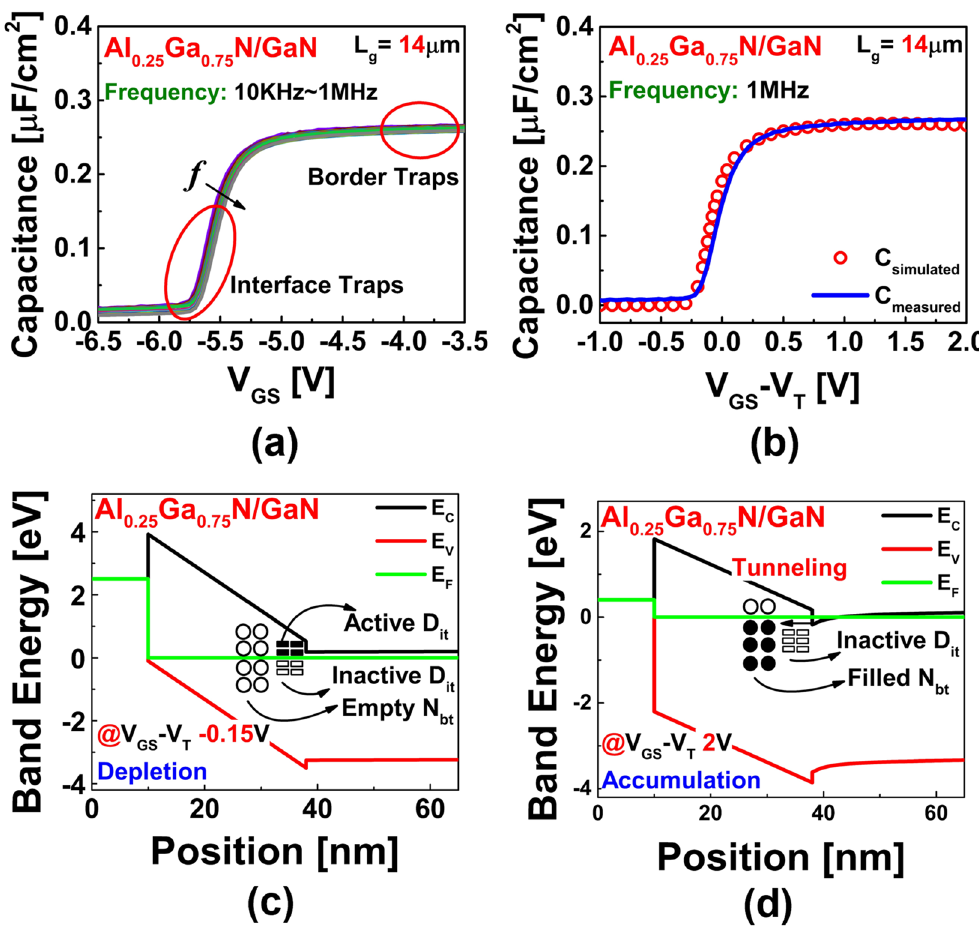
Figure 2. ( a ) Results of frequency-dependent C–V measurements showing active response region of traps. ( b ) Comparison between measured and simulated C–V characteristics. Simulated band diagram showing trap behavior ( c ) in depletion and ( d ) in